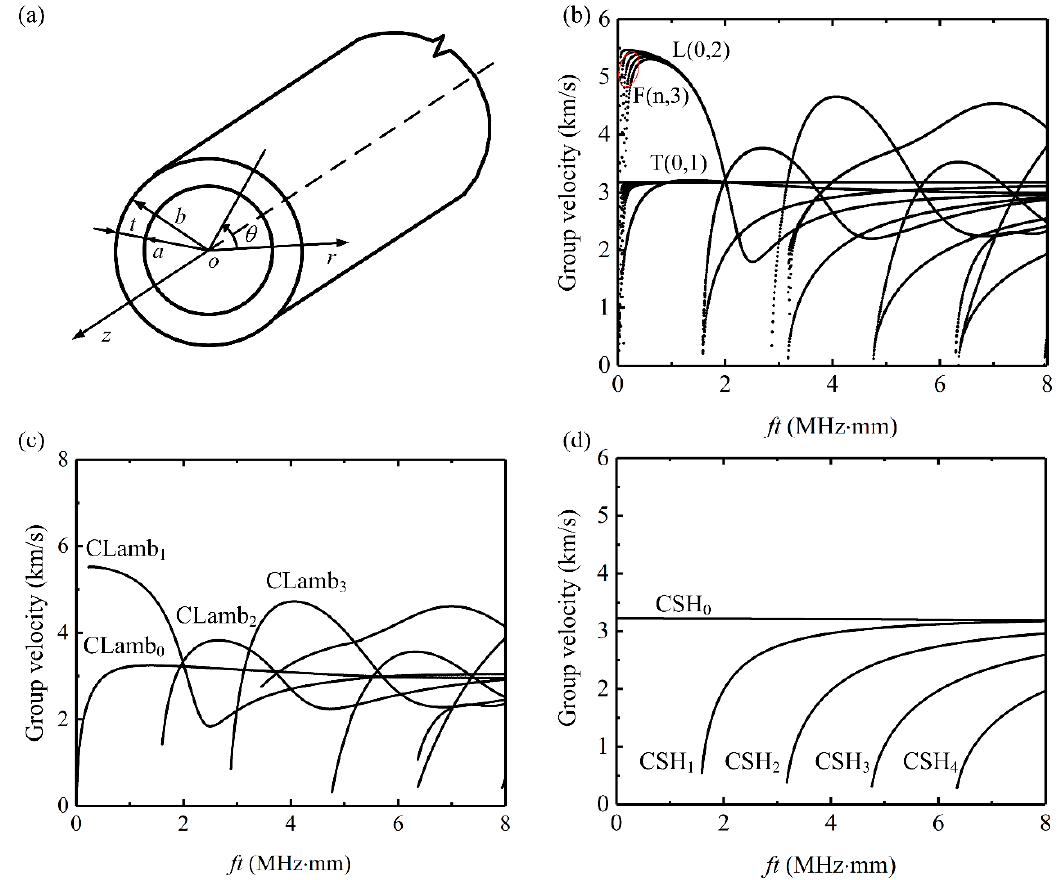
Figure 1. Group velocity dispersion curves of axial and circumferential guided waves in a steel pipe (outer diameter 720 mm, wall thicknesses 11 mm, Young’s modulus 210 GPa, density 7850 kg/m 3 and Poisson’s ratio 0.33): ( a ) pipe axes configuration; ( b ) axial guided waves (F modes only shown up to 4th order); ( c ) circumferential Lamb (CLamb) waves and; ( d ) circumferential shear horizontal (CSH) waves.